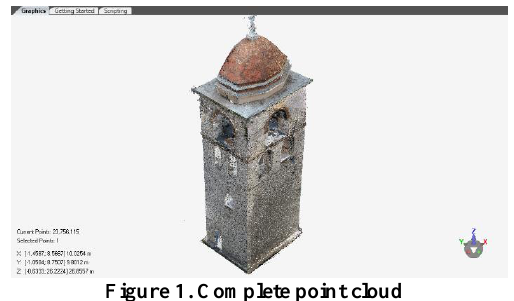
Figure 1. Complete point cloud